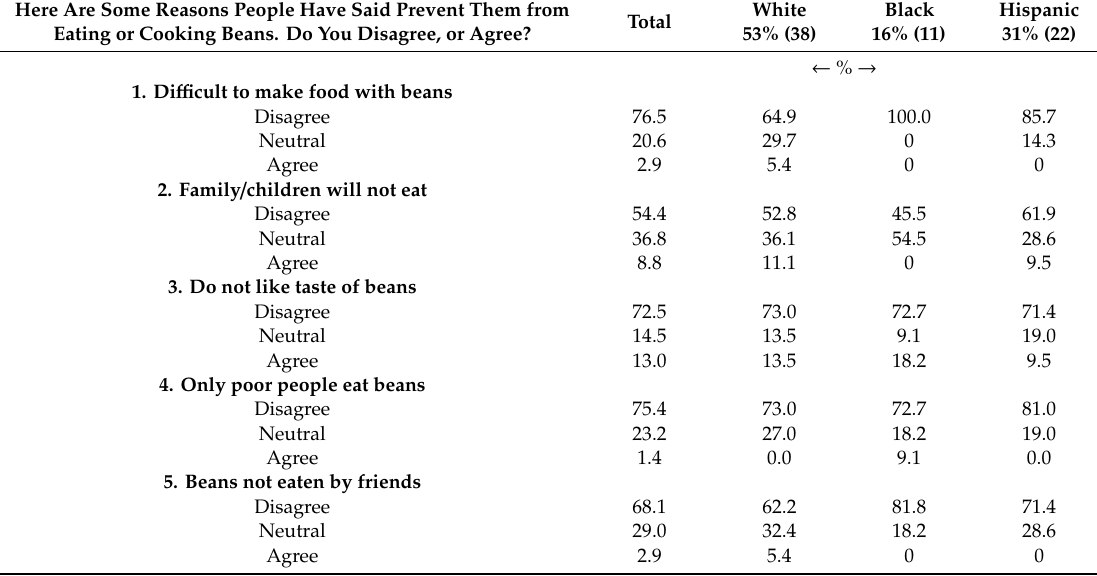
Table 4. Attitudes, perceptions, and consumption preferences for beans among low-income Arizona men by race / ethnicity category (N =